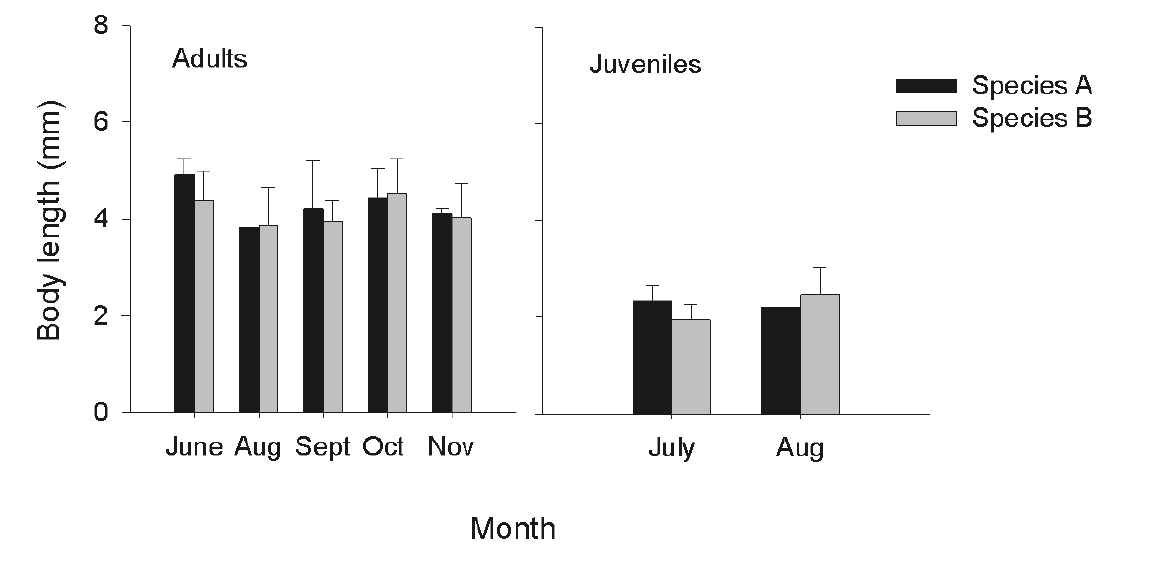
Figure 2. Body lengths of Hyalella amphipods of species A and B for adults and juveniles for all months (mean ± standard deviation, where